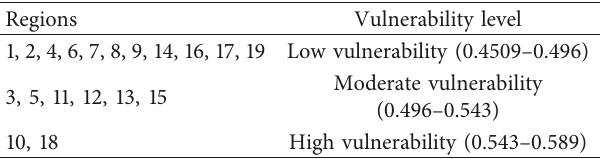
Table 16: Vulnerability categories of different regions in Qazvin city. Regions Vulnerability